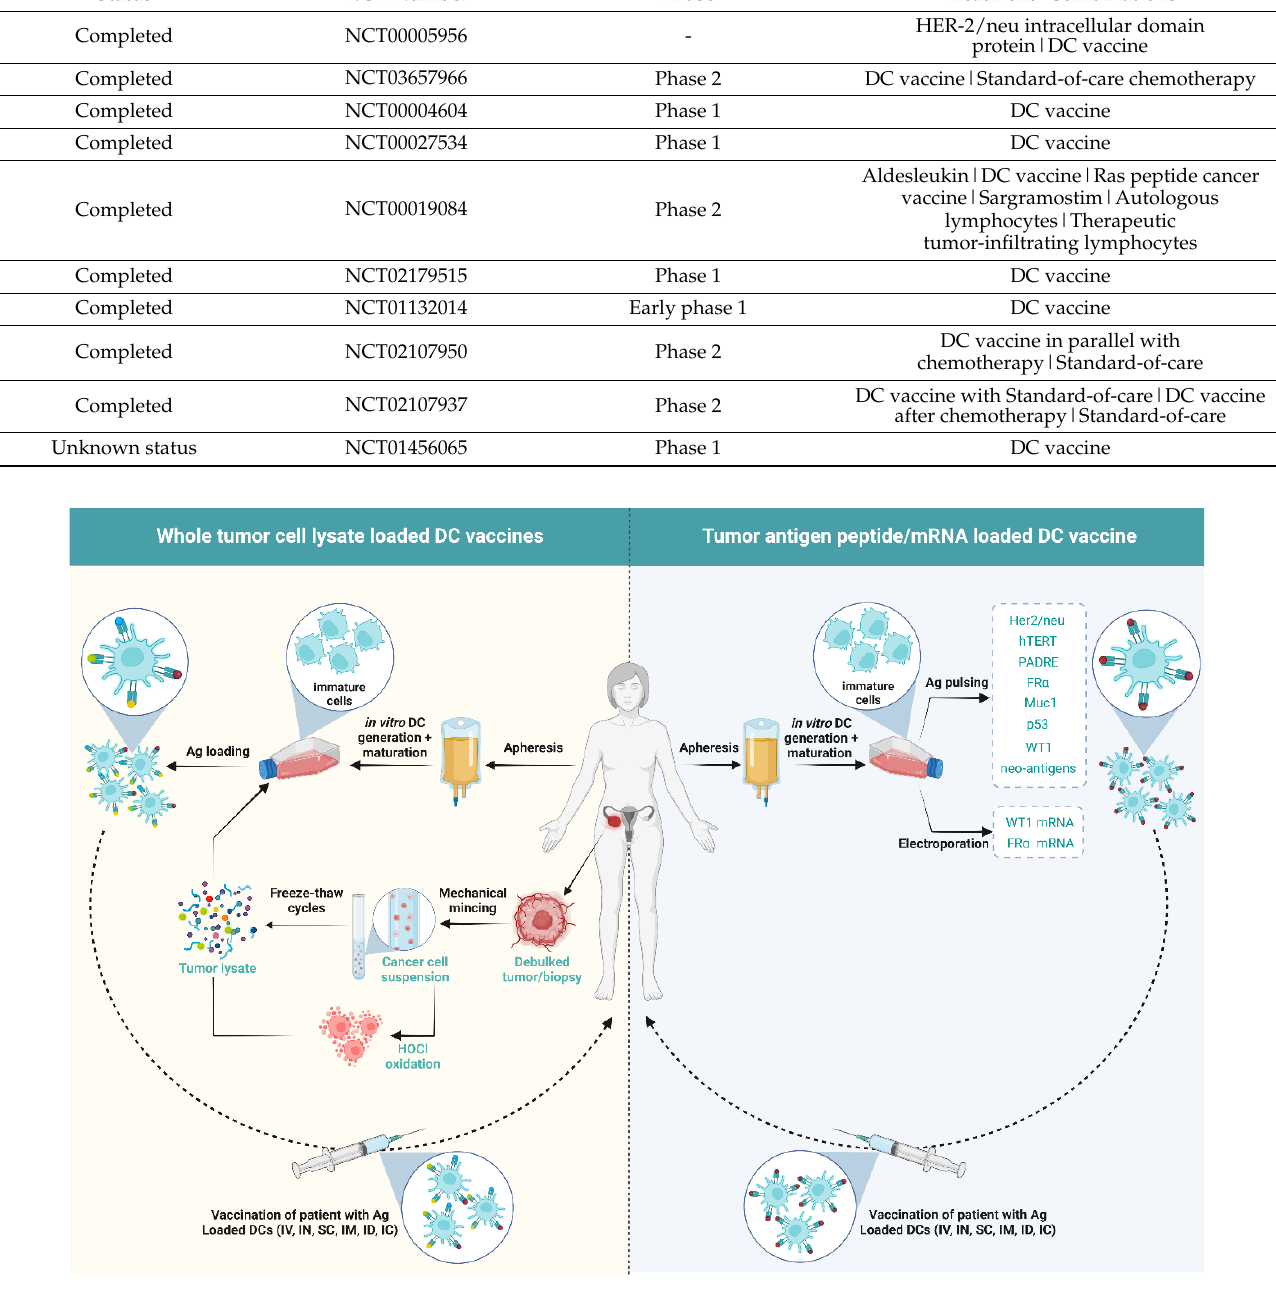
Figure 2. Schematic overview of dendritic cell vaccination strategies used in ovarian cancer. Ag, antigen; HOCl, hypochlorous acid; IV, intravenous; IN, intranodal; SC, subcutaneous; ID, intradermal; IC, intracutaneous. Figure created with Biorender.com.